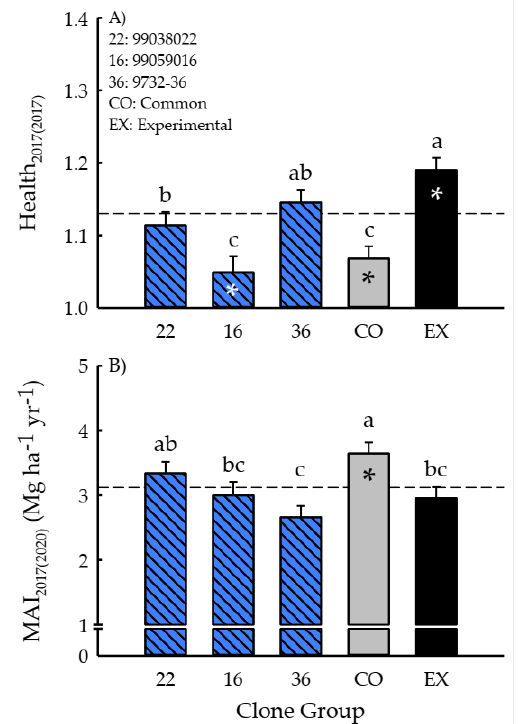
Figure 3. First-year tree health ( A ) and fourth-year mean annual increment (MAI) ( B ) of three clone groups (i.e., NRRI = 22, 16, 36; Common; Experimental; see Table 3 for definitions) tested in six phytoremediation buffers (i.e., phyto buffers) established in 2017 (i.e., the 2017 Buffer Group) in the Lake Michigan watershed of eastern Wisconsin, USA. Error bars represent one standard error of the mean. The dashed line represents the overall mean, and asterisks indicate means different than the overall mean at p < 0.05. Bars with different letters are different at p < 0.05. See Section 2 for complete tree health definitions (1 = optimal health, 2 = good health, 3 = moderate health, 4 = poor health, and 5 =